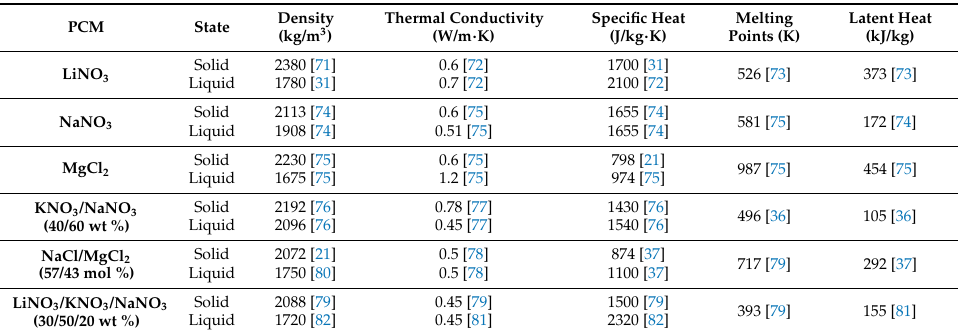
Table 2. Thermal properties of PCM